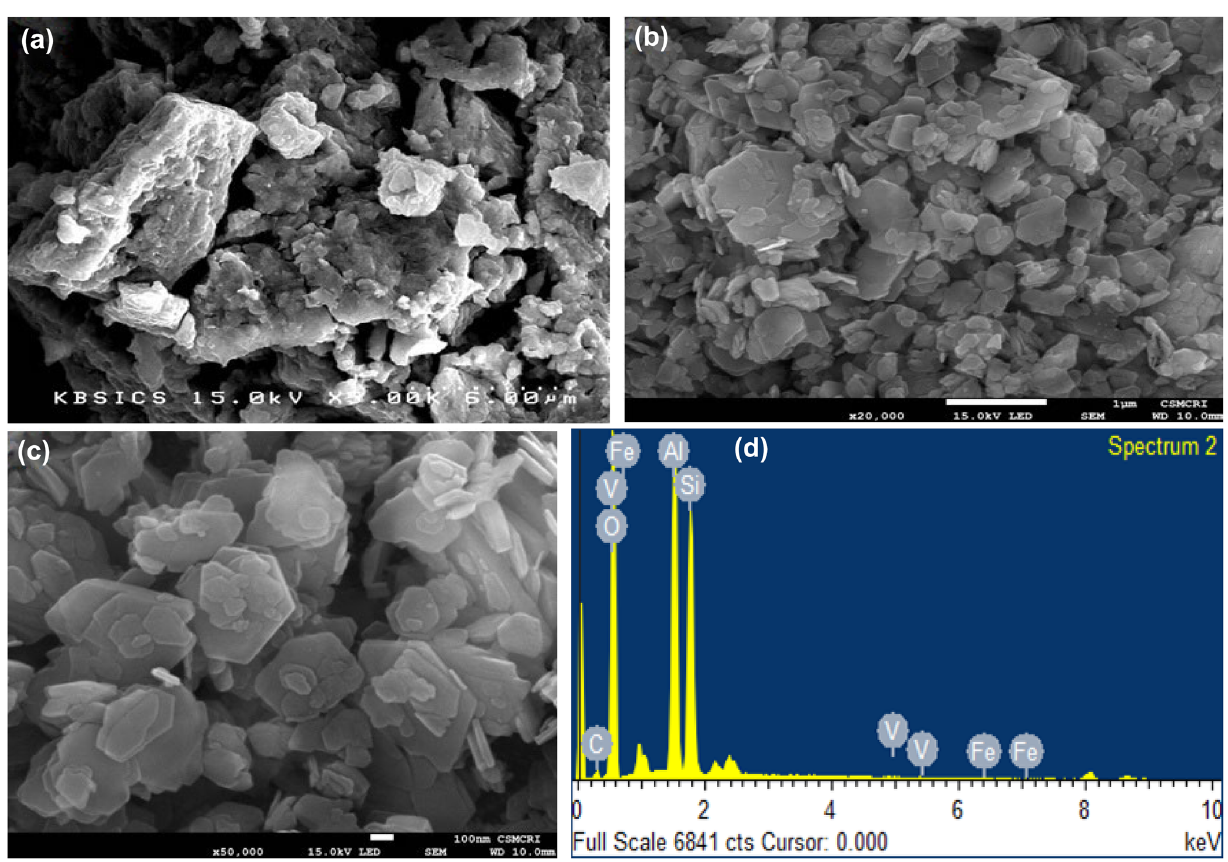
Fig. 3 SEM images of a MVPA, b , c : MVPA/Kaolin d SEM–EDX spectra of